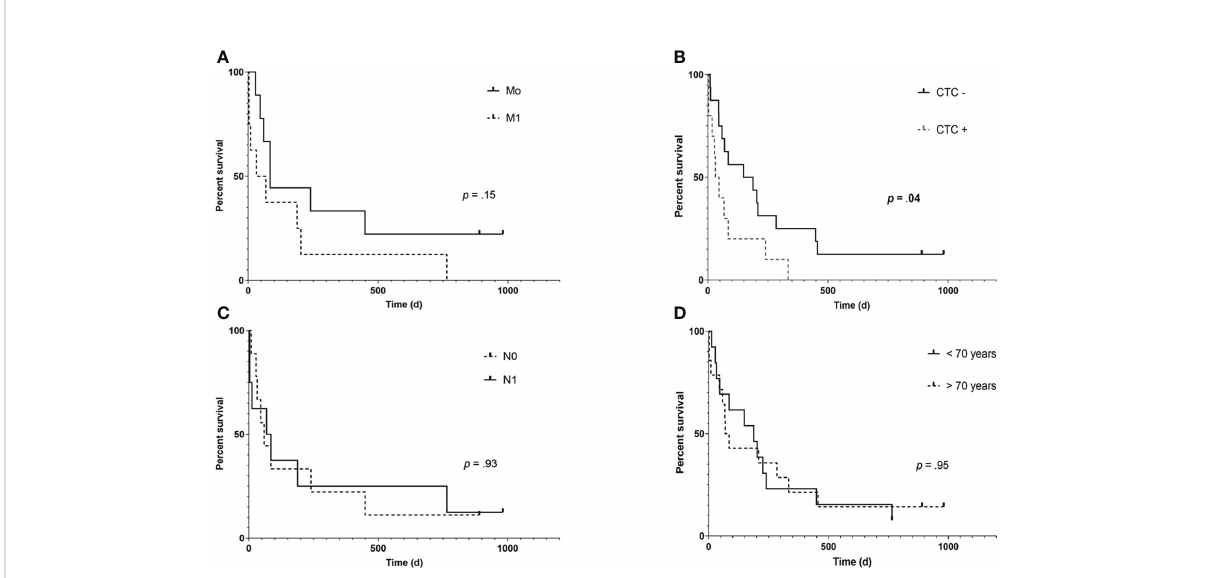
FIGURE 2 Kaplan- Meier overall survival (OS) estimates according to the presence of distant metastases (A) , CTC (B) , positive lymph node status (C) and older age (D) in patients of the training cohort (n= 27). While presence of extrahepatic metastases shows a trend of impaired survival (85 vs 50